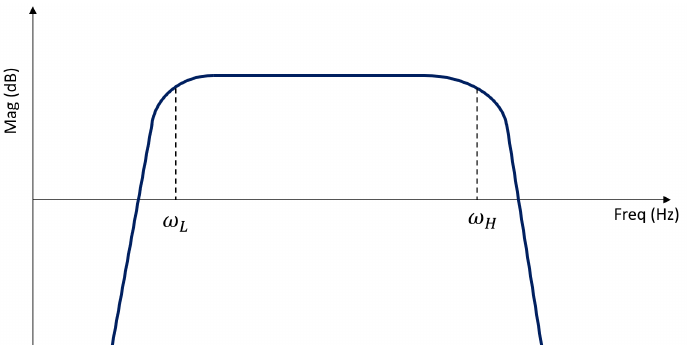
Figure 7. Band-pass filter, W Y , is used to emphasize specific frequency region of Youla transfer function in the H 2 norm